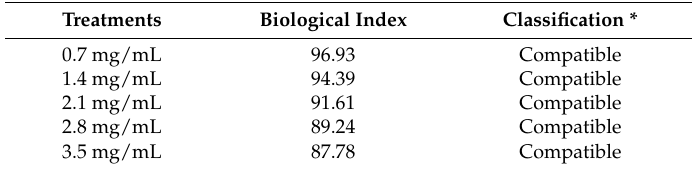
Table 1. Biological index-based classification of the toxicological impacts of various concentrations of phytol on B. bassiana B6903.